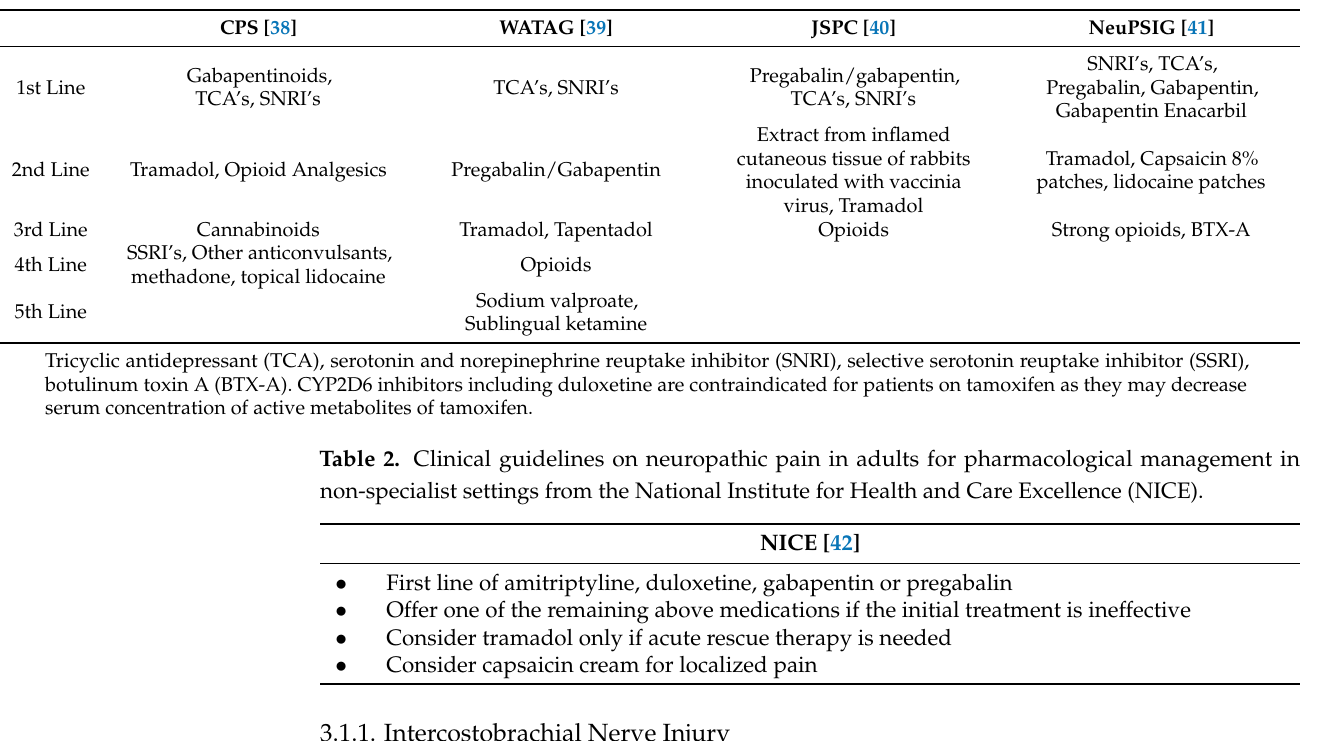
Table 1. Recommendations for the pharmacologic management of neuropathic pain from the Canadian Pain Society (CPS), the Western Australian Therapeutic Advisory Group (WATAG), the Japan Society of Pain Clinicians (JSPC) and the International Association for the Study of Pain (NeuPSIG).